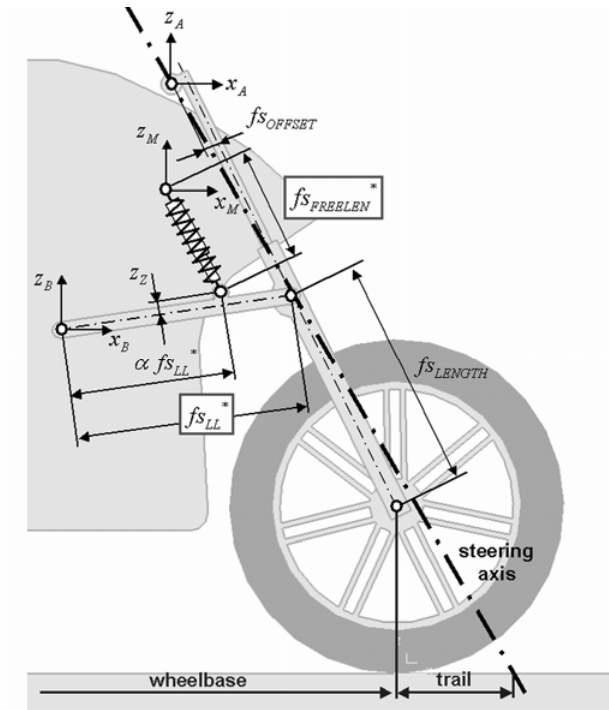
Fig. 1. Front Suspension layout and geometrical parame- ters (inputs for the optimization problem)